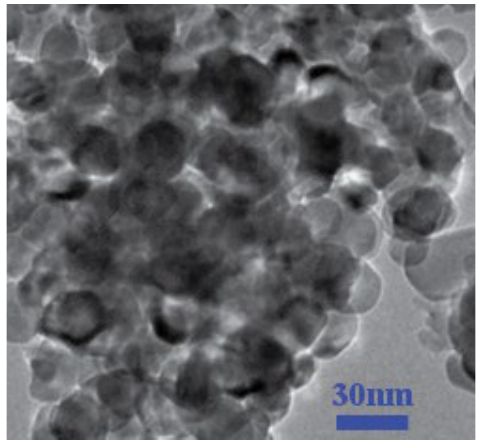
Fig. 1. SARA analysis of the crude oil.